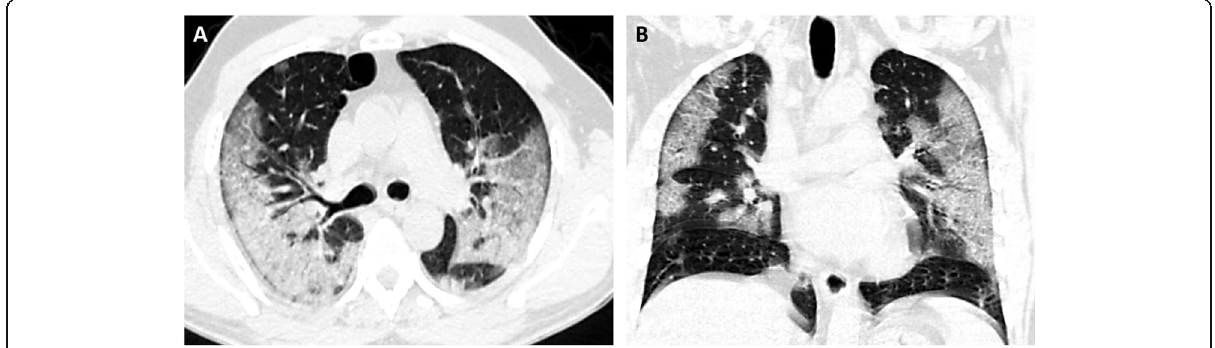
Fig. 4 Non-contrast CT done 6 days after initial complaint of a 68-year-old male with high grade fever and tachypnea, rt RT-PCR +VE. ( A , B ): A , axial and B , coronal non-contrast CT scan lung window show bilateral peripheral ground glass density with thickened interlobular and intralobular lines (crazy-paving pattern) involving upper, middle lobes, and